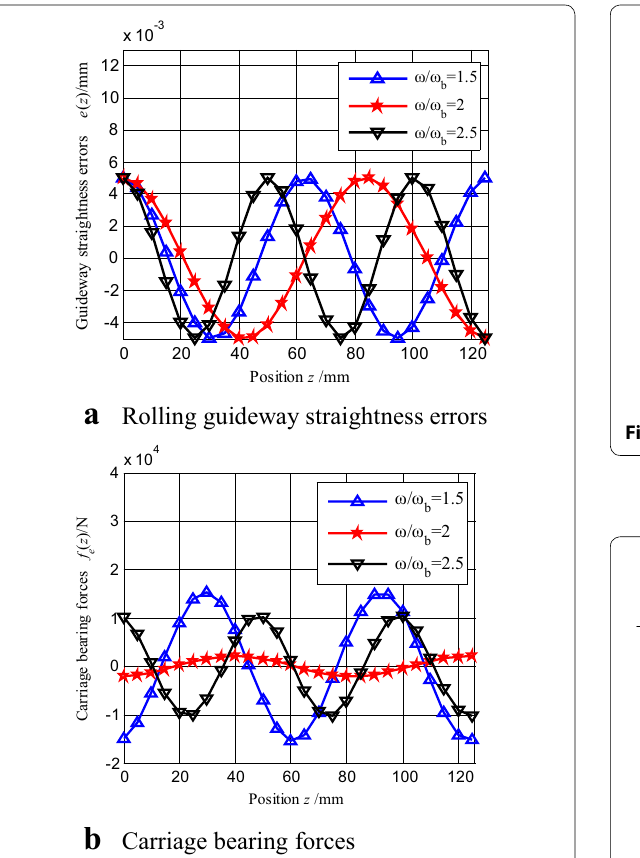
Figure 6 Single carriage and profile error at various